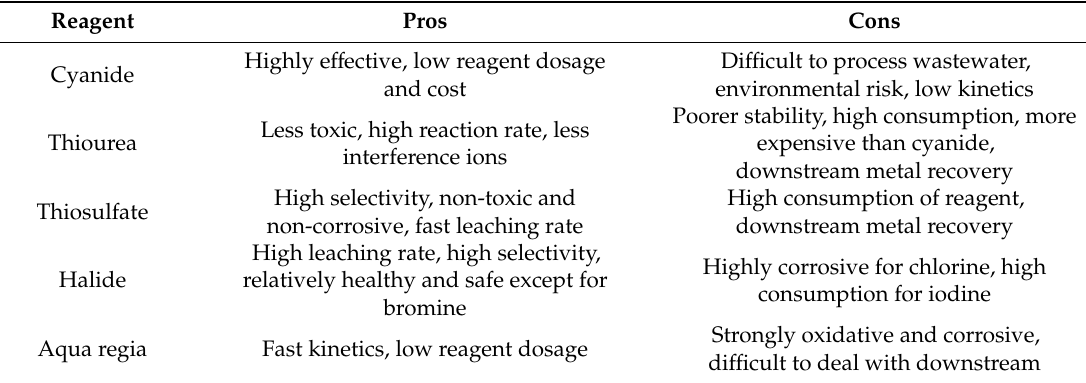
Table 4. Comparison of potential leaching reagents for gold